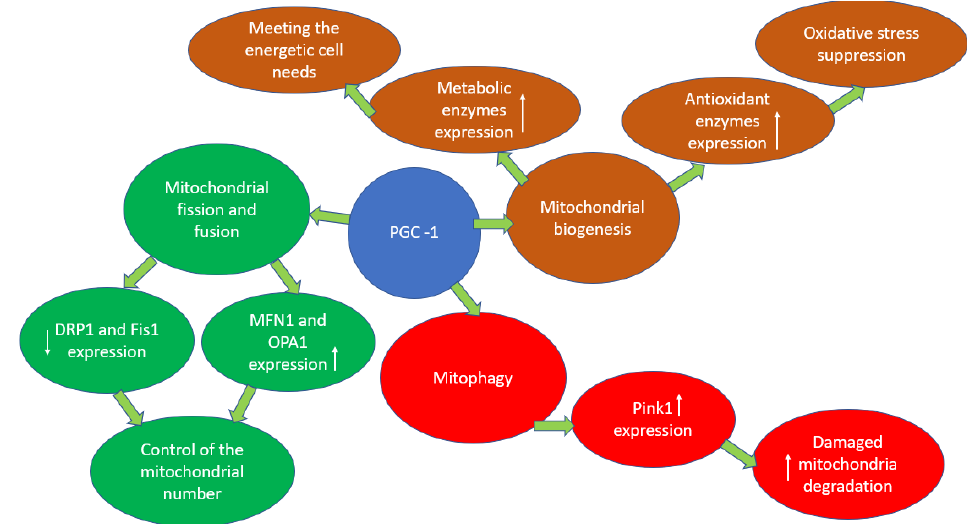
Figure 1. The multiple roles of PGC-1 α in the regulation of mitochondrial dynamics.